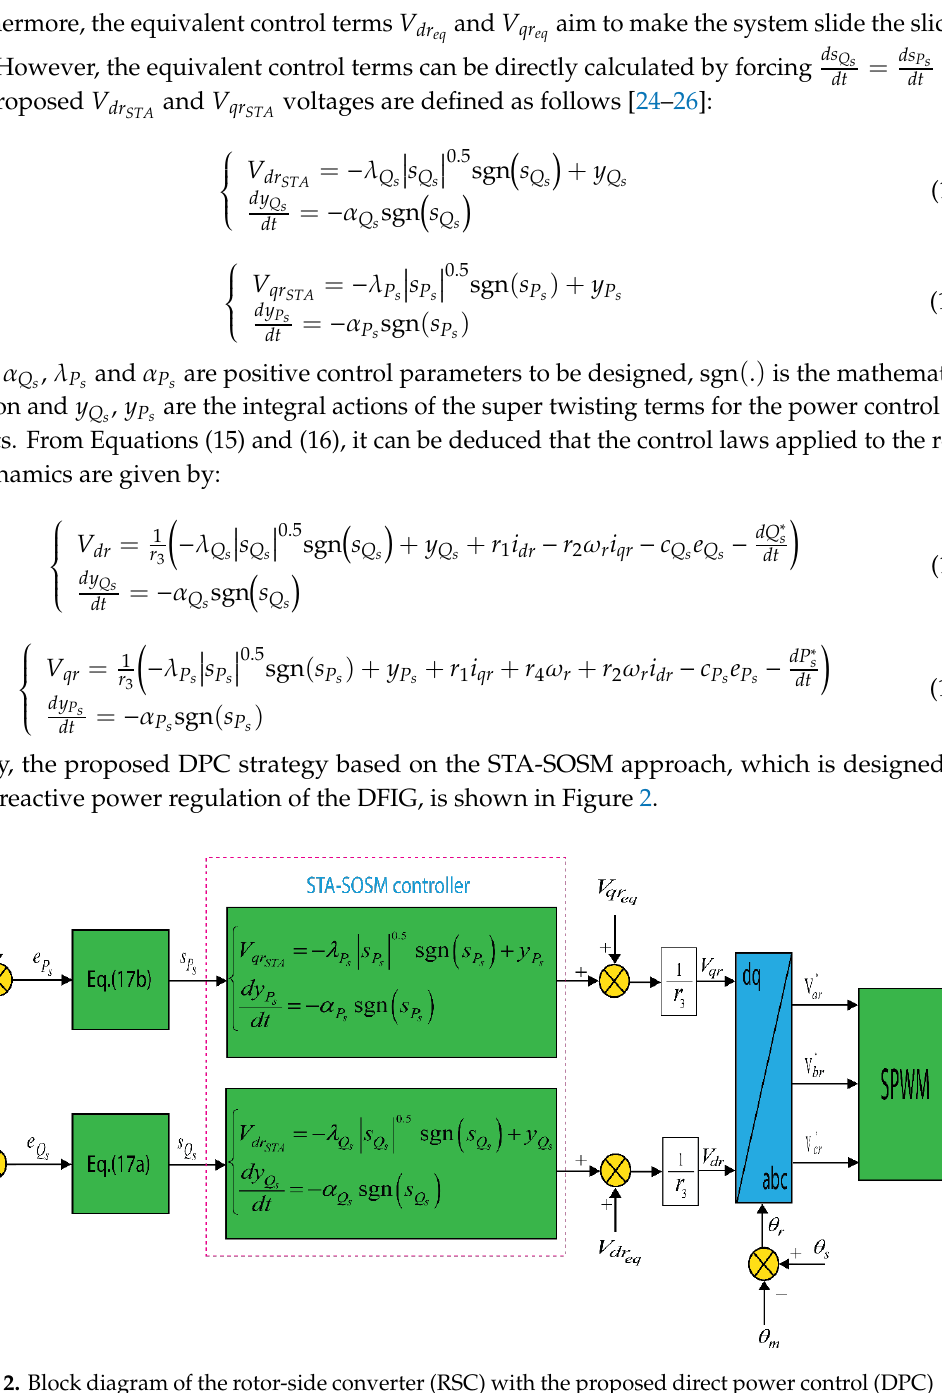
Figure 2. Block diagram of the rotor-side converter (RSC) with the proposed direct power control (DPC) strategy based on super twisting algorithm-based second-order sliding mode (STA-SOSM) controller.